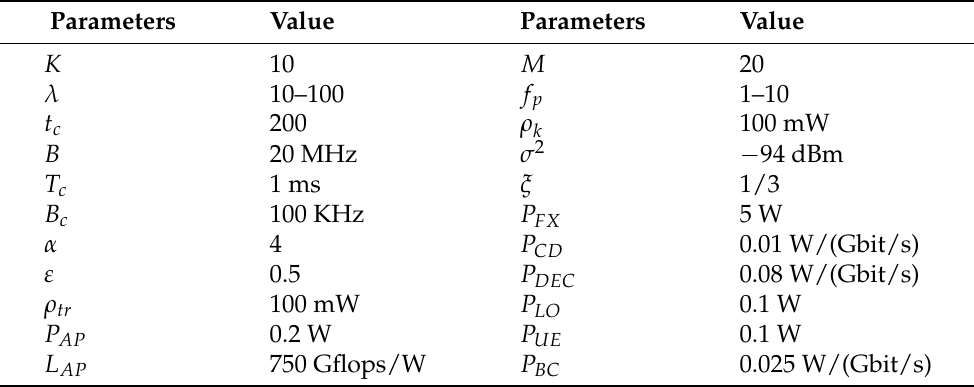
Table 2. Important parameters considered in the simulation